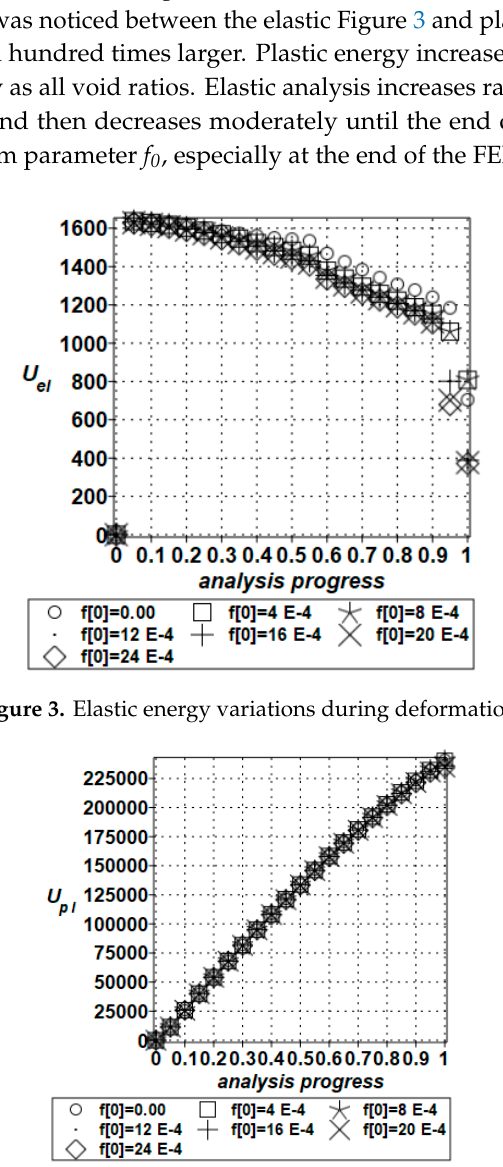
Figure 5. Expected values of elastic energy fluctuations.